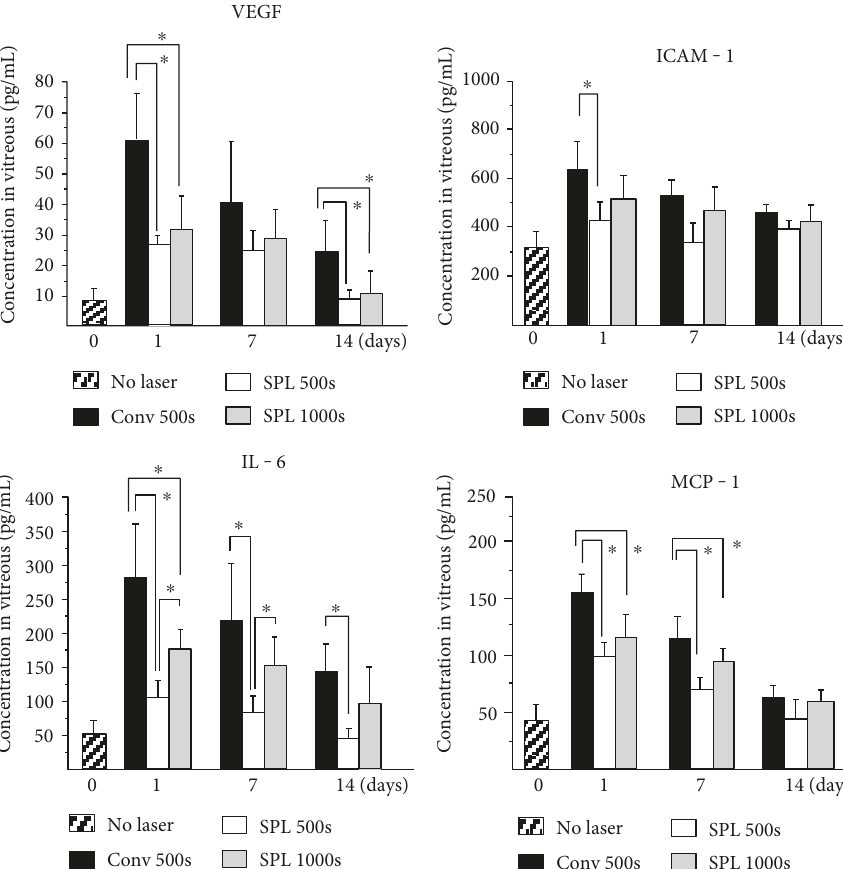
Figure 4: Alteration in the vitreous levels of in fl ammatory and angiogenic cytokines after panretinal photocoagulation (PRP) using the conventional laser with 500 spots (Conv 500s), short-pulse laser (SPL) with 500 spots (SPL 500), and SPL with 1000 spots (SPL 1000s). Concentrations of VEGF, IL-6, ICAM-1, and MCP-1 in the vitreous body were measured before and on 1, 7, and 14 days after PRP. Statistically signi fi cant di ff erence as compared to the Conv group ( ∗ p < 0 05 ). Vertical bars indicate standard deviation. ( n = 8 ).